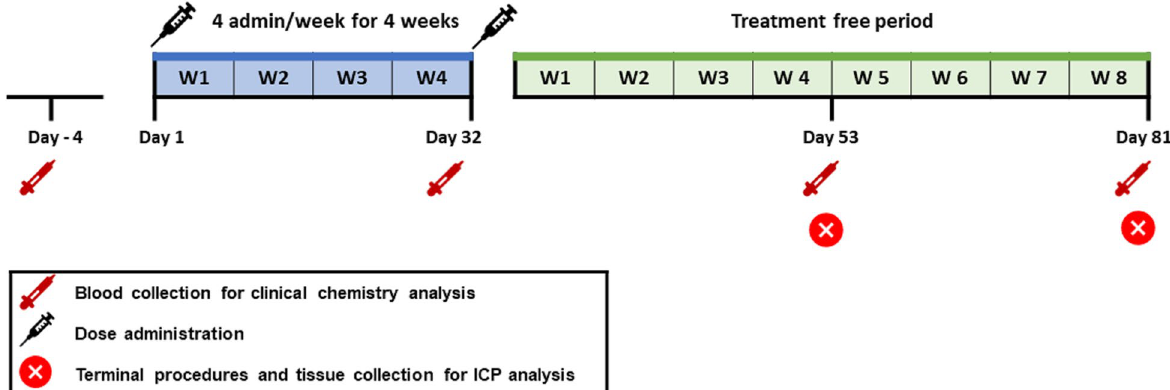
Fig. 1 Experimental design. Subtotally nephrectomised and healthy rats were randomised to 4 exposure groups for each scheduled sacrifice at day 28 ( n 10 rats in groups 1, 2, and 3; n 5 in group 4) or day 56 ( n 9 in groups 1, 2, and 3; n 5 in group 4) after the end of the 4-week = = = = treatment period. Animals in each group received a single daily intravenous injection of the respective gadolinium-based contrast agent at a dose of 0.6 mmol/kg body weight 4 times a week for 4 consecutive weeks. At scheduled sacrifice, blood and tissues were harvested for Gd determination by inductively coupled plasma/mass spectrometry. As not all the animals completed the study, the sample size was reduced to 8 rats in groups 1 and 2, to 9 in group 3 at day 28, and to 8 in groups 1 and 3, and 7 in group 2 at day 56. Blood was sampled for urea and creatinine determinations predose (day 4), at the end of dosing (day 32) and before scheduled sacrifice (day 53 and day −